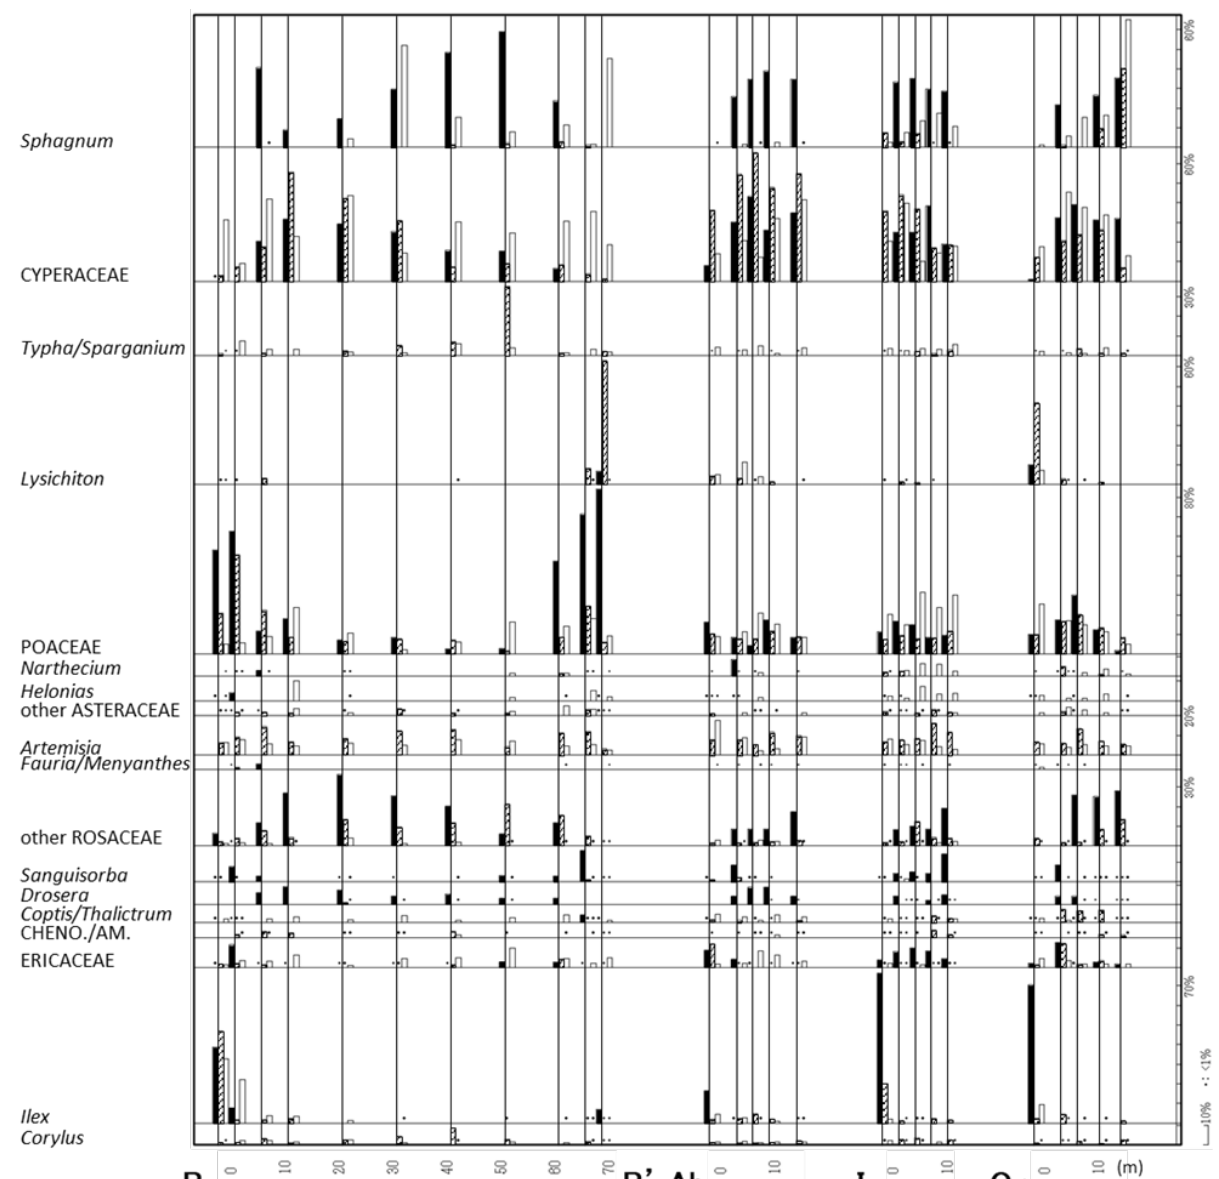
Figure 5. Diagram comparing percent coverage of plants (solid), surface pollen percentages (hatched) and pollen percentages in 915 CE (open) of selected non-trees on Lines B, Ab, Ix and Qr. Pollen percentages are expressed as a proportion of the total non-tree pollen and spore count. Plus signs in the diagram indicate abundances < 1.0 %. CHENO./AM. stands for